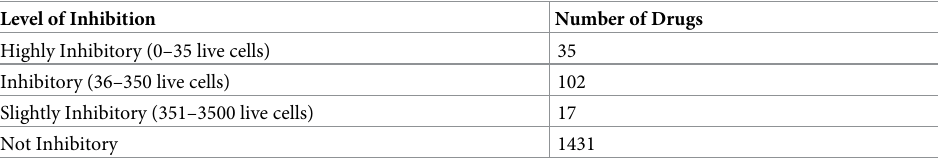
Table 1. Summary of drugs that cause growth inhibition or cell